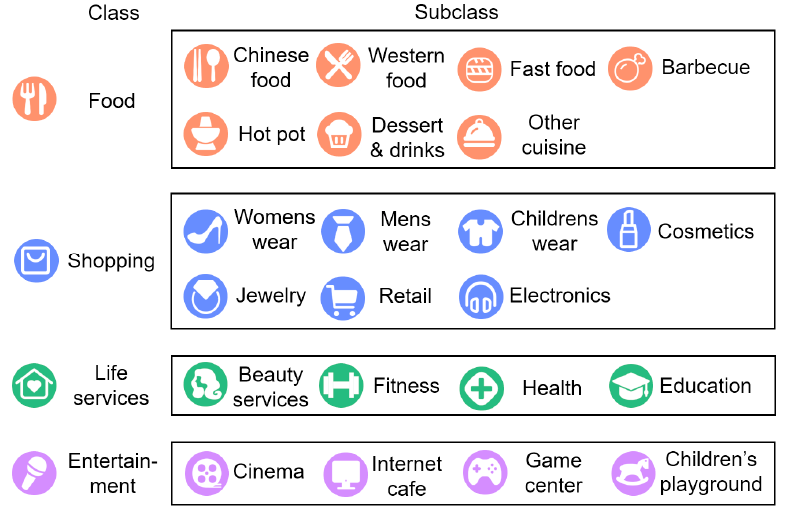
Figure 7. Class- and subclass-level POI symbol design.